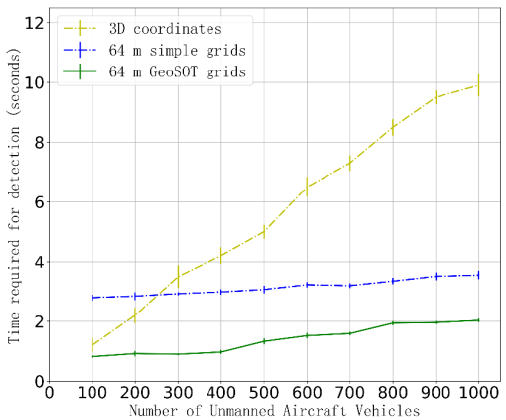
Figure 7. Time required for detecting collisions with three methods. The three methods consist of calculations with three-dimensional coordinates, calculations with simply 64 m grids, and spatial database queries with 64 m GeoSOT-3D grids.